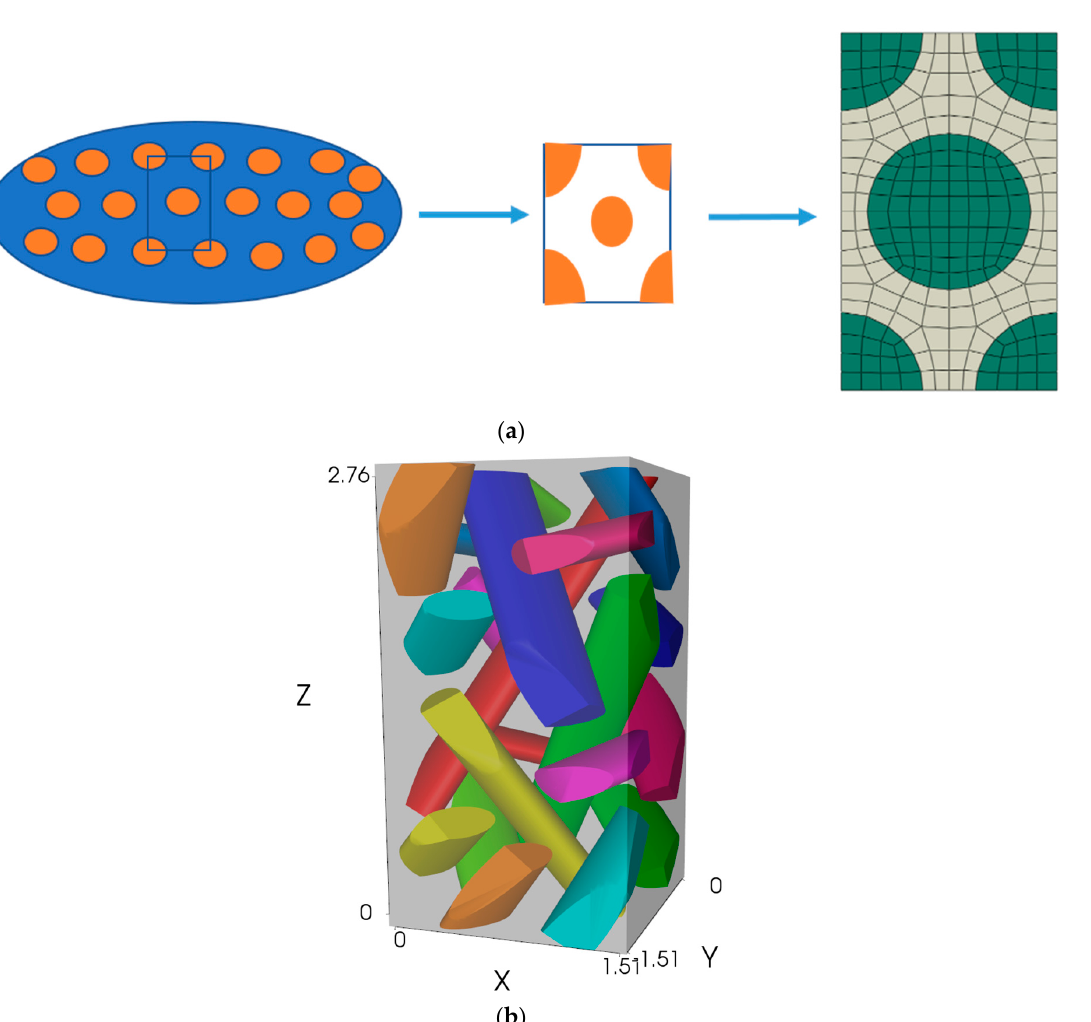
Figure 4. ( a ) Micro-scale model with fiber and matrix; ( b ) meso-scale model with yarn trajectory and matrix (transparent).